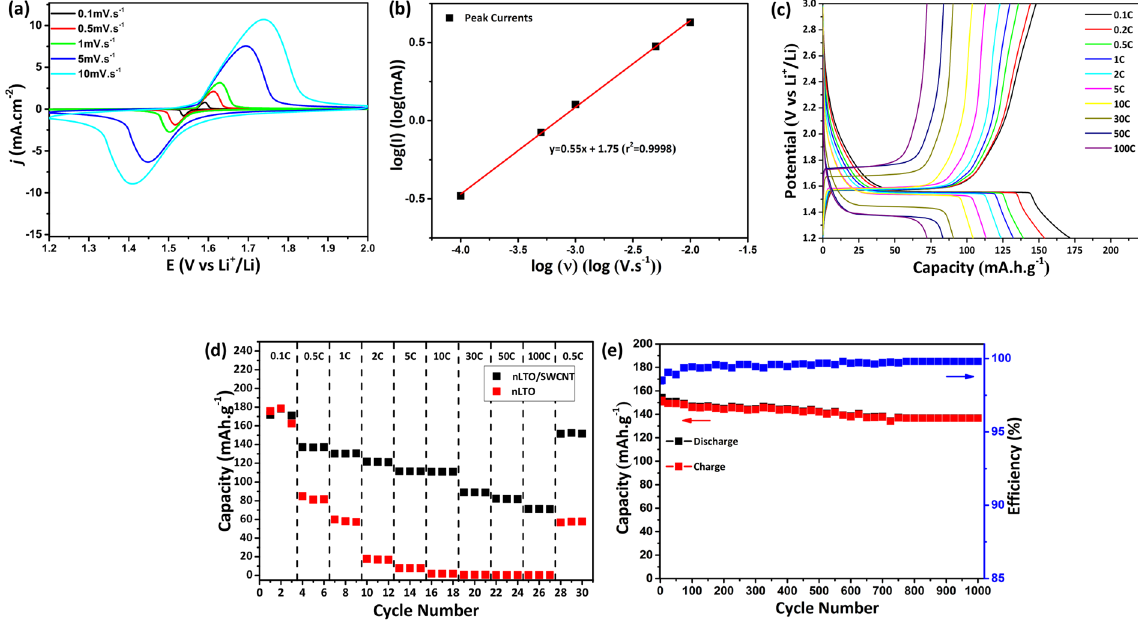
Figure 5. Electrochemical properties of nLTO/SWCNT composites: cyclic voltammograms acquired between 1.2 V and 2 V at different scan rates ( a ); linear fitting for the CV peaks intensity as function of the applied scan rate ( b ); representative charge-discharge curves at several currents ( c ); rate capability ( d ) and cycling performance cycling performance for 1000 cycles at 1C (3.30 μ A.cm − 2 ) ( e